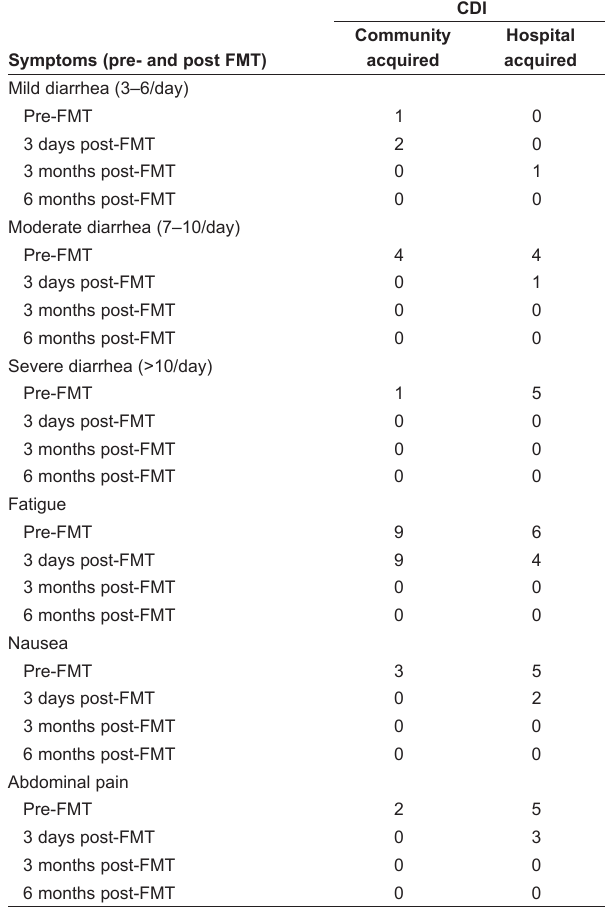
TAble 3 Comparison of clinical features between community- acquired and hospital-acquired Clostridium difficile infection (CDI), both pre- and post-fecal microbiota